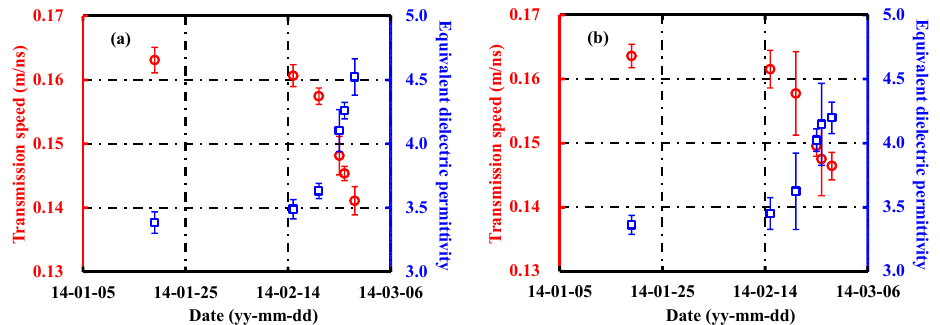
Figure 13. Radar transmission speed and equivalent dielectric permittivity calculated by measured ice thickness and round-trip travel times: ( a ) Site A; ( b ) Site B.